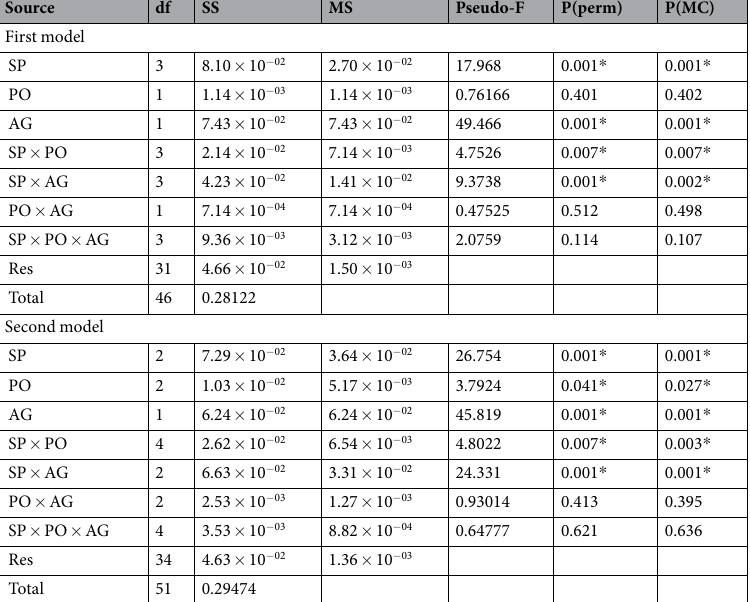
Table 2. Permutational multivariate analysis of variance (PERMANOVA) results for comparisons of FA concentration by population (PO), Species (SP), Age (AG), and their interactions. Tests were run using euclidean distances among samples and 999 permutations in the software Primer ® , including the Montecarlo correction for small sample size. The first Permanova model considered only the populations where all species were found and included the effects of the factors AG (two levels: young, old), PO (two levels: Palinuro and Pantelleria), SP (four levels: C . caespitosa , B . europaea , A . calycularis , L . pruvoti ), and their interactions. The second Permanova model considered only the species that were found in all populations and included the effects of the factors AG (two levels: young, old), PO (three levels: Calafuria, Palinuro, Pantelleria), SP (three levels: C . caespitosa , B . europaea , L . pruvoti ), and their interactions. df degrees of freedom, SS sum of squares, MS mean squares, P(perm) significance, P(MC) significance after Montecarlo correction. Significant effects (p < 0.05) are indicated with an asterisk ( *